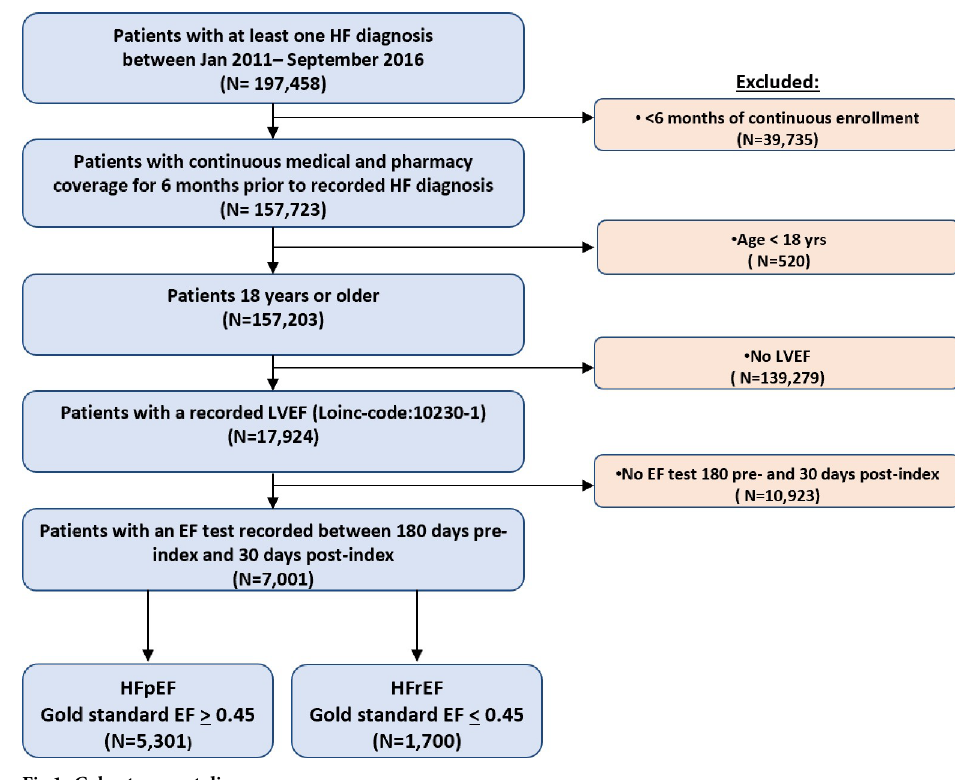
Fig 1. Cohort consort